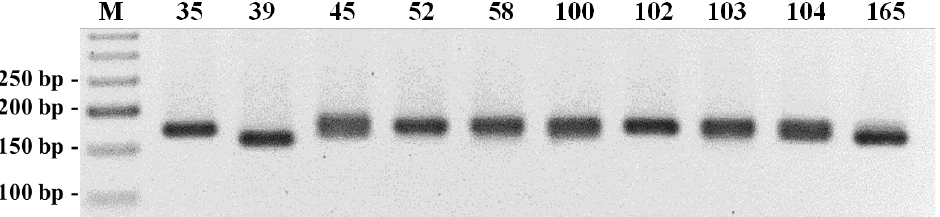
Figure 2. Agarose (3%) gel electrophoresis of the preliminary amplification of the SSR locus MT317527 among 10 D. tenuifolia accessions. among 10 D. tenuifolia accessions.